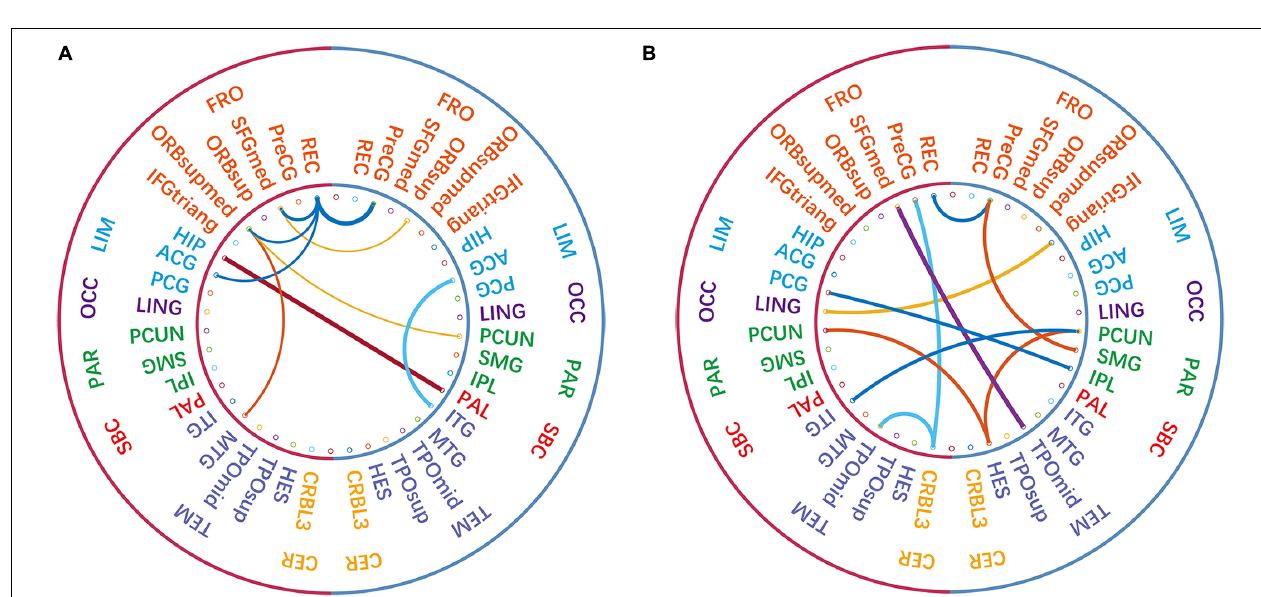
FIGURE 9 | The sub-network associated with ASD and the strength of its contribution to ASD.